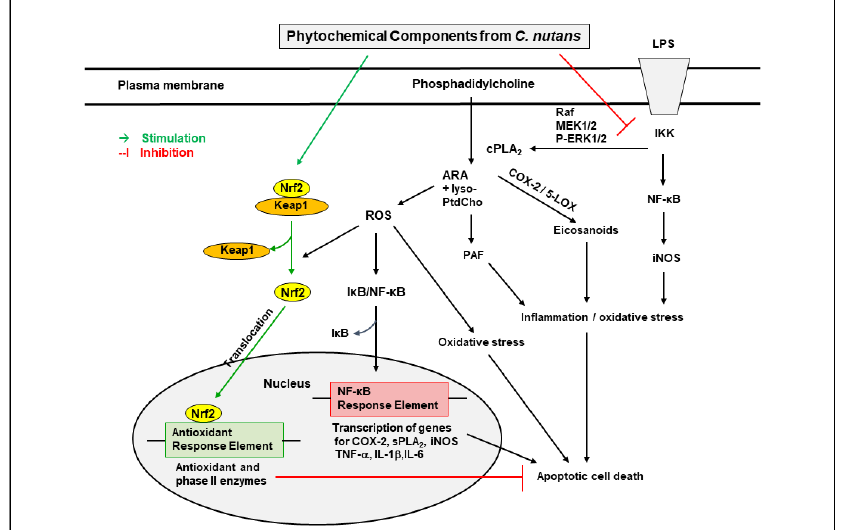
Figure 2. Inflammatory and oxidative stress pathways targeted by C. nutans and its phytochemical